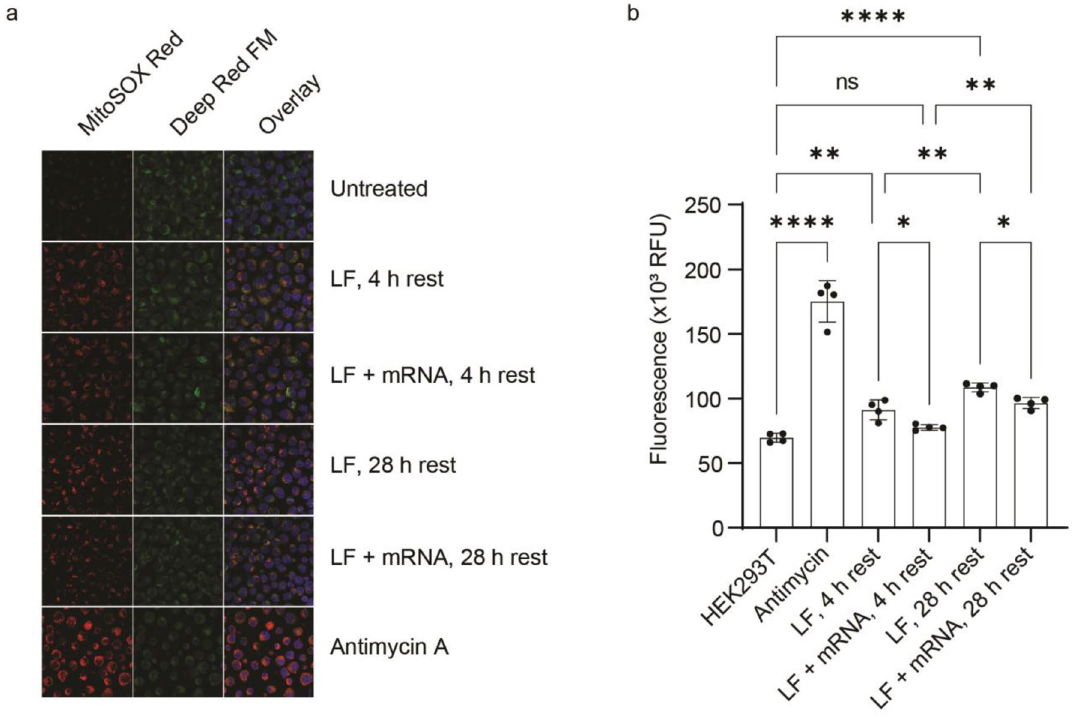
Figure 6. ROS production in HEK 293T cells in response to LNP exposure with and without mRNA. ( a ) MitoSOX stained cells reveal the presence of ROS (colored in red). Deep Red FM staining (colored in green) shows intact mitochondria. Overlay panels indicate that ROS originate in mitochondria. ( b ) Quantitation of MitoSOX fluorescence in cells. Dots represent data points obtained using technical replicate samples. Error bars represent mean deviation. Stars indicate significance: p < .05 (*), p < .01 (**), and p < .001